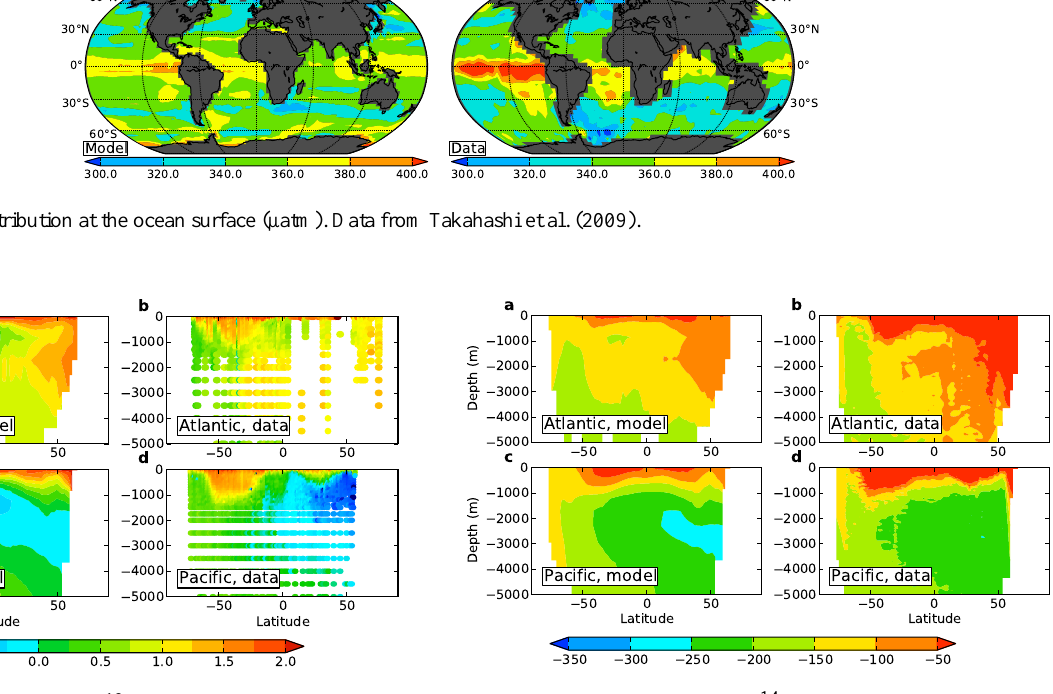
Figure 18. Zonal average of the δ 13 C distribution in the ocean (‰). Data from Schmittner et al. (2013).